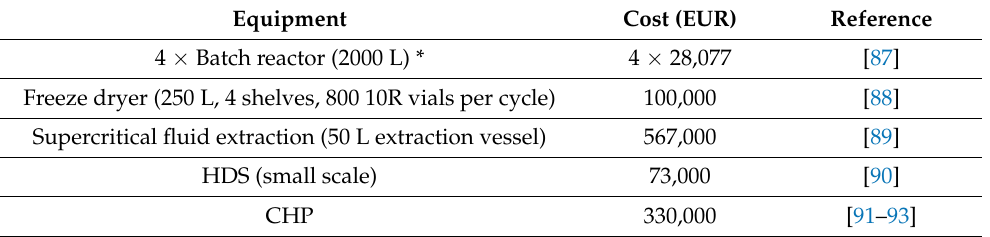
Table A3. Capital cost of main C. cohnii biorefinery equipment for 4 Ton DHA/year production